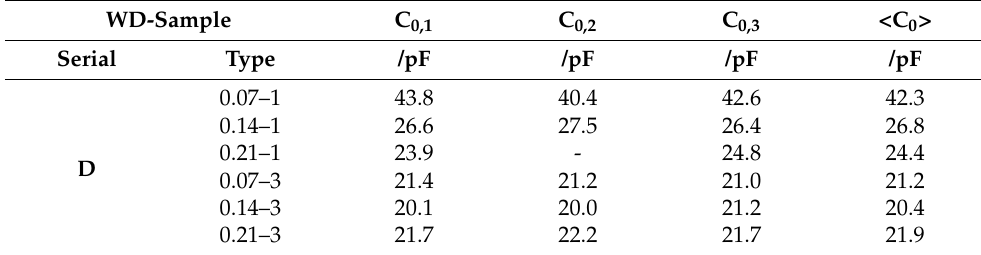
Table 2. Measured electrical capacities of dry dressing samples (without the addition of